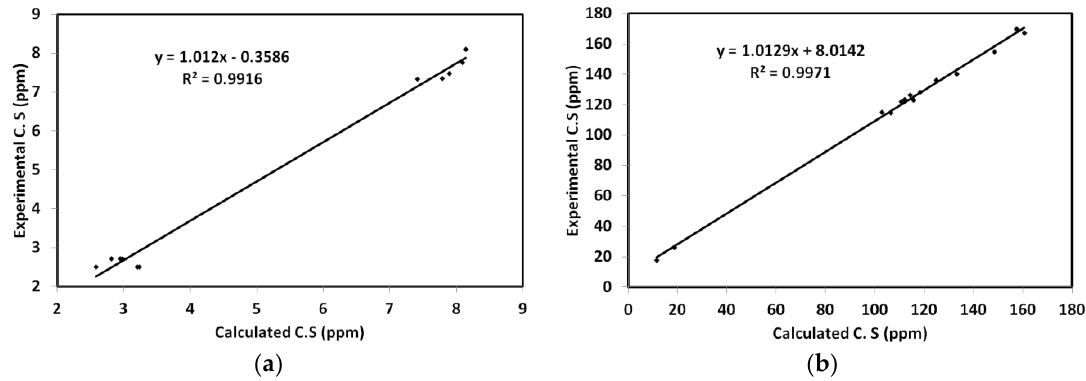
Figure 14. 1 H-NMR and 13 C-NMR correlation diagram: ( a ) experimental; ( b ) calculated.